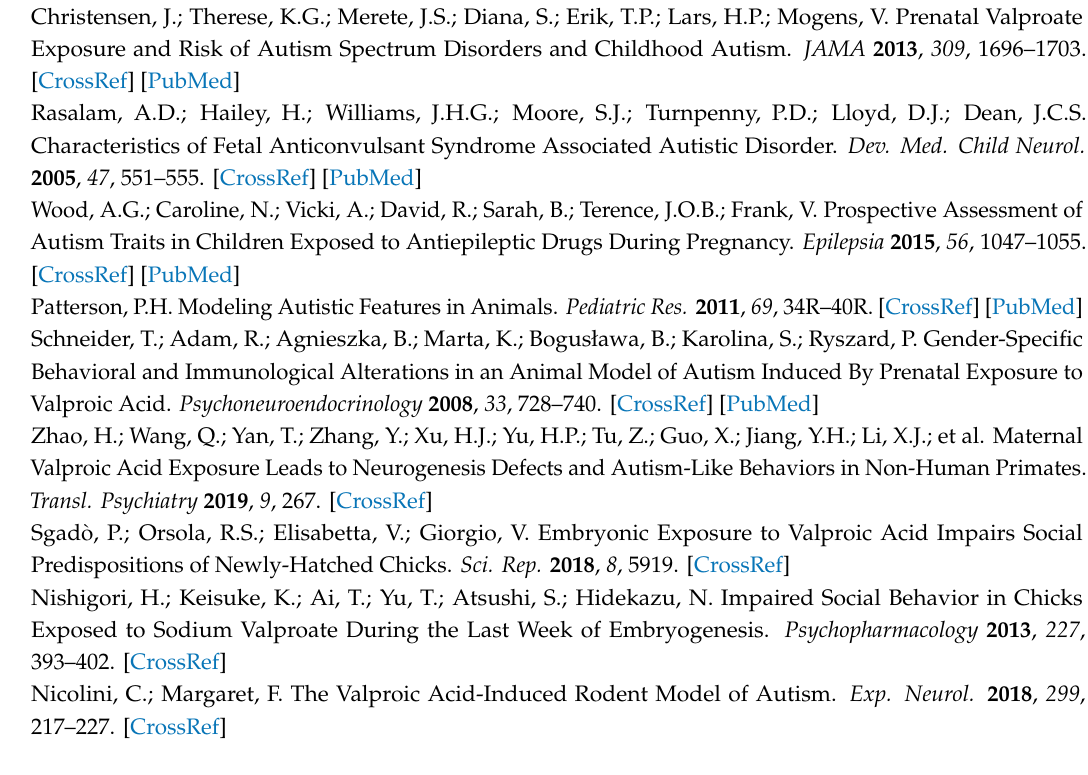
Table S1: List of primers used for qPCR. Primers for th1 and th2 according to Baronio et al. [18], 18S, htr3a , htr3b , htr4 according to Messina et al.